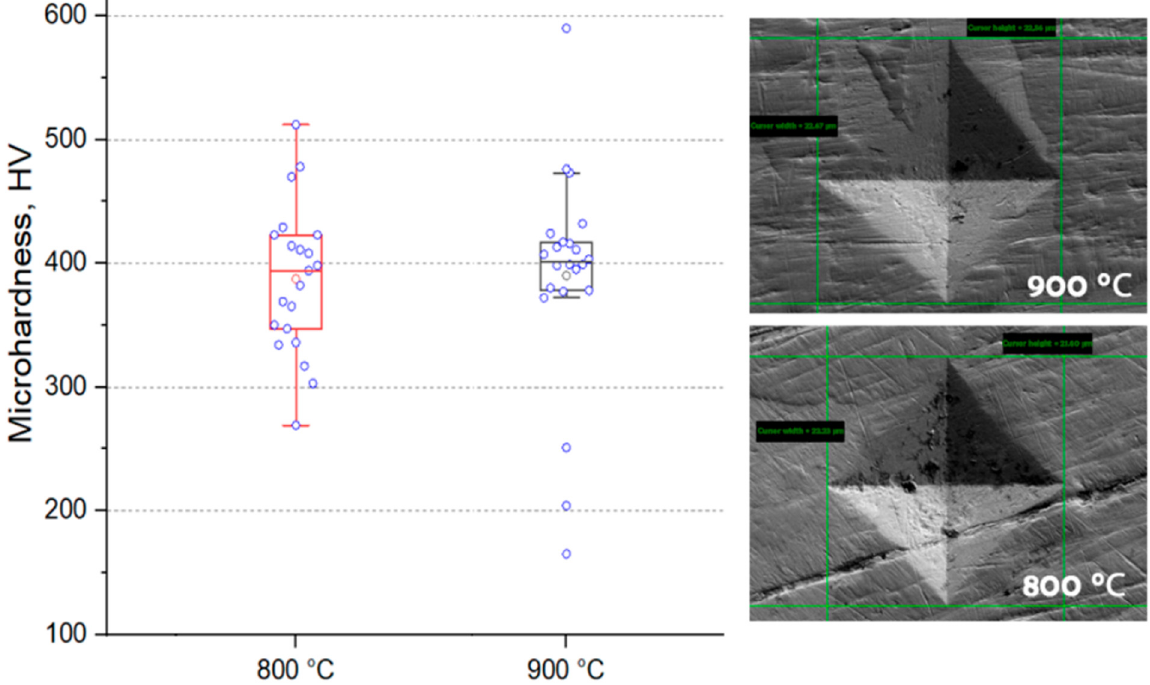
Figure 6. Microhardness value for materials obtained by spark plasma sintering.